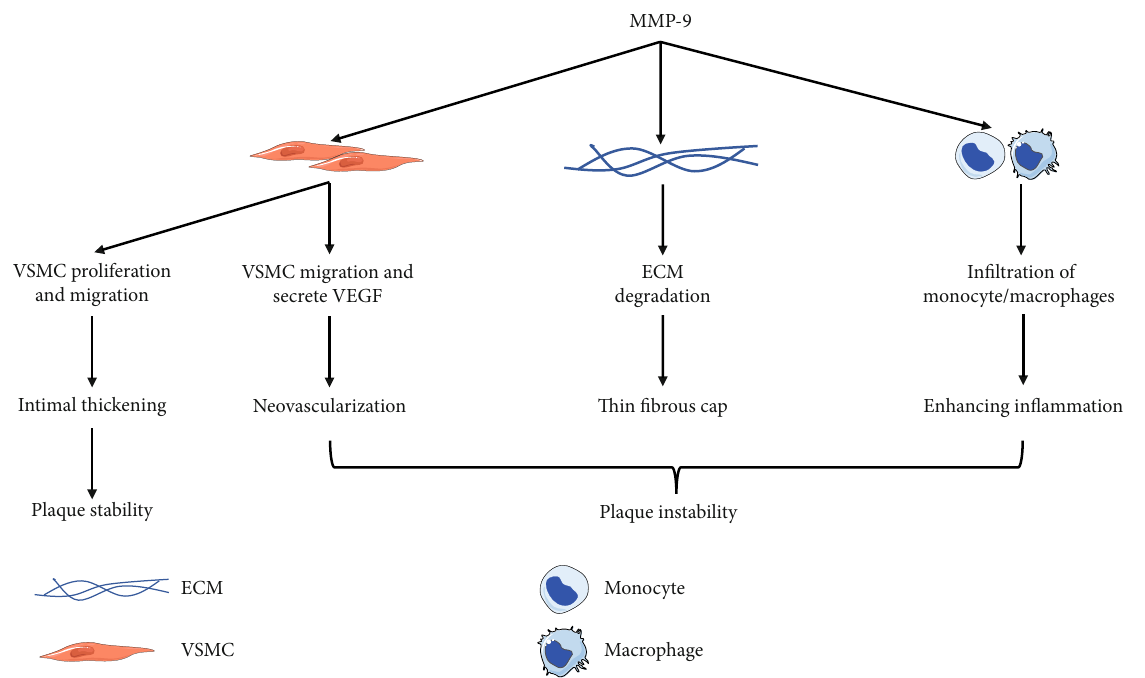
Figure 1: Emerging roles of MMP-9 in atherosclerosis, atherothrombosis, and vulnerable plaques. Abbreviations: MMP-9: matrix metalloproteinase-9; ECM: extracellular matrix; VSMC: vascular smooth muscle cell; VEGF: vascular endothelial growth